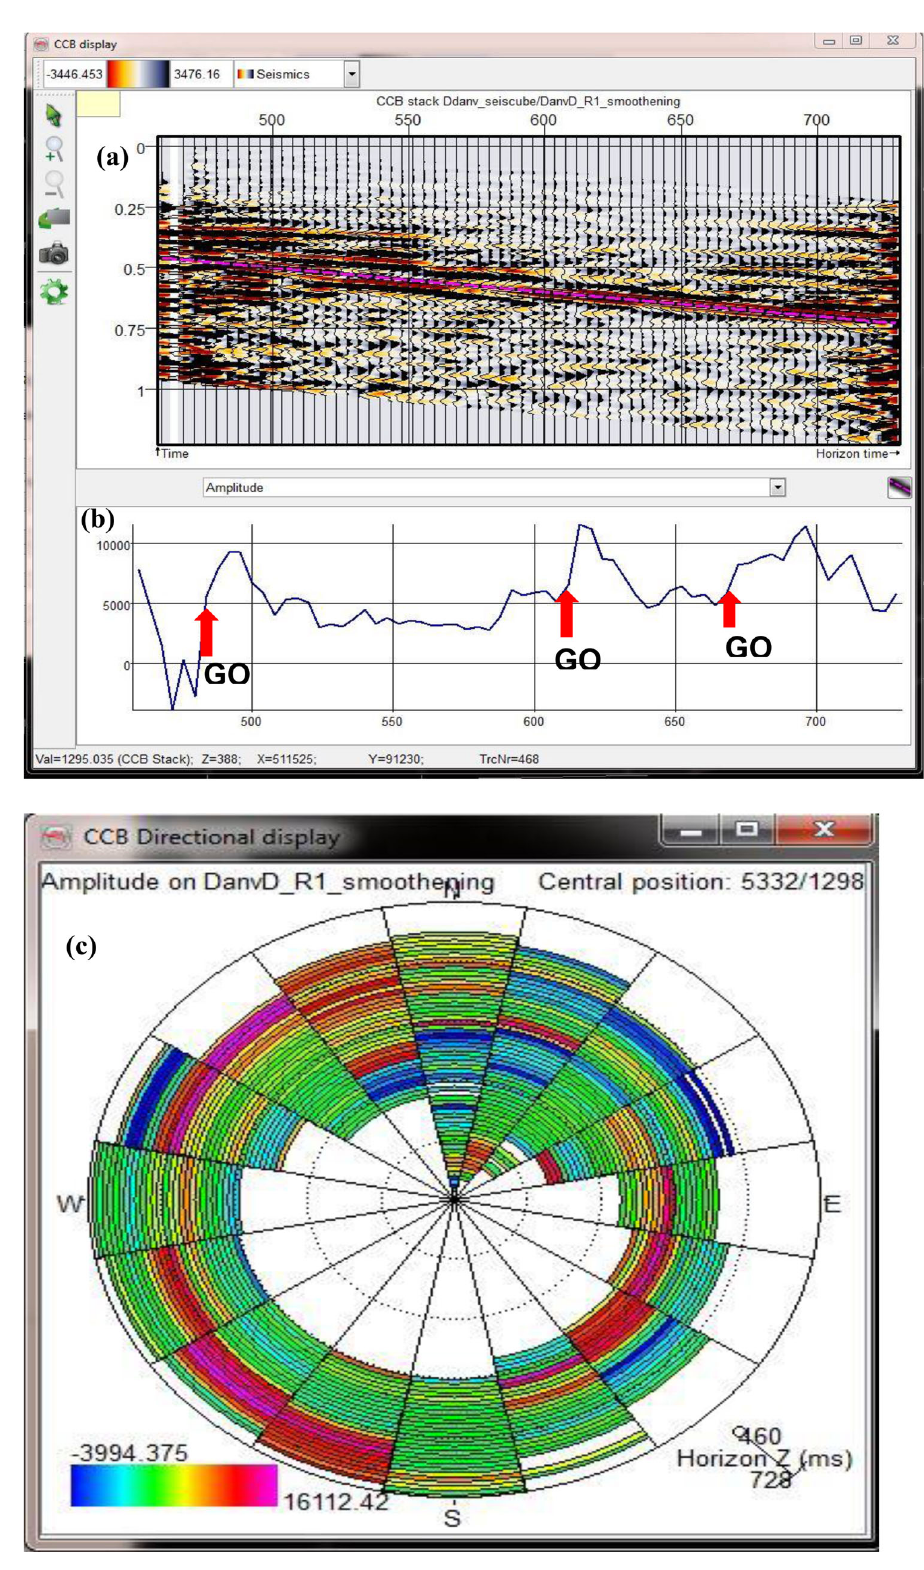
Fig. 12 Reservoir R1 ( a ) CCB stacked ( b ) Crossplot of stacked amplitudes vs. bin